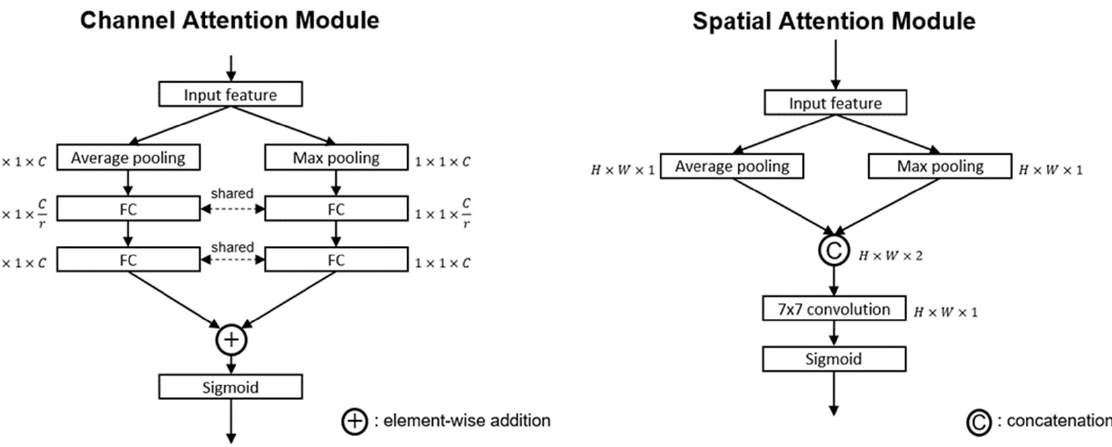
Figure 6. The structure of the attention module, H, W , and C are the height, width, and channel of feature map.